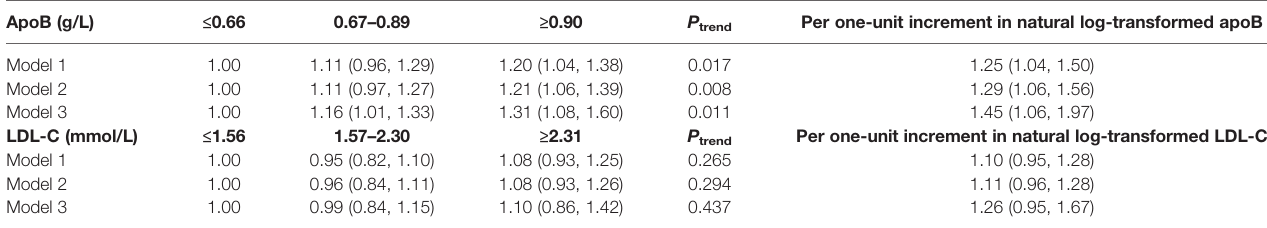
TABLE 3 | RR (95% CIs) for residual risk of coronary atherosclerotic heart disease according to levels of apoB and LDL-C. ApoB (g/L) ≤ 0.66 0.67 – 0.89